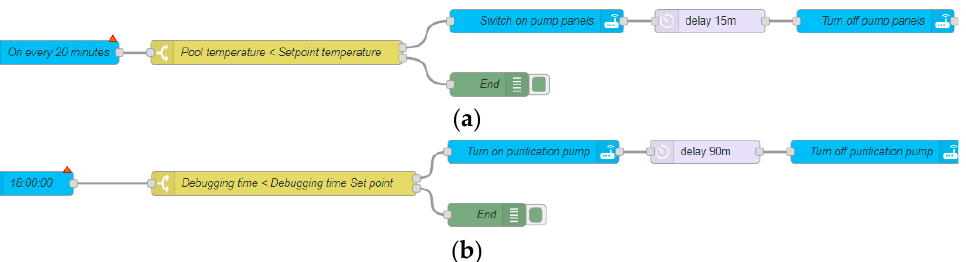
Figure 5. ( a ) Flow chart of solar collector pump by time. ( b ) Time-based debugging